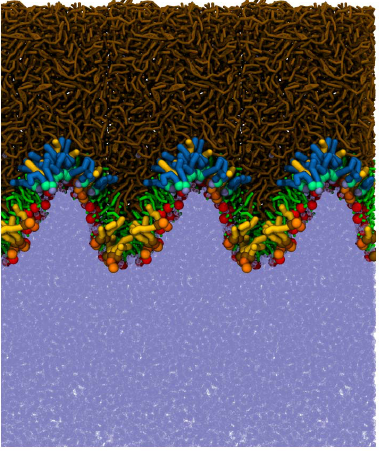
Figure 6. The sorting of polar lipids in regions of different curvature in the compressed system (APPL=45 A˚ 2 ). Color coding: SM tails in gold and headgroups in orange, Cer tails in blue and headgroups in light-green; POPC and POPE tails in green and headgroups in red, non-polar lipids (TG and CE) in brown, water beads in ice-blue. For presentation purposes, three periodic images in the lateral direction are depicted (corresponding to about 27 nm).